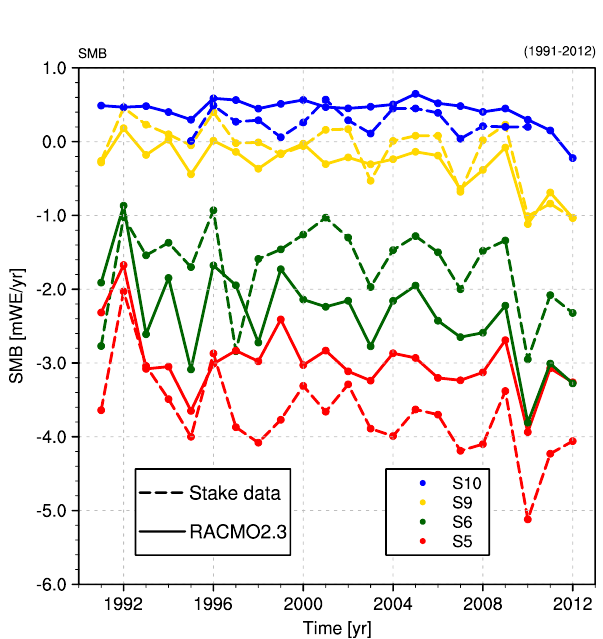
Figure 7. Time series of observed (AWS) and modelled (RACMO2.3 and 2.1) annual mean SMB along the K-transect (mWEyr − 1 ) for the period 1991–2012.